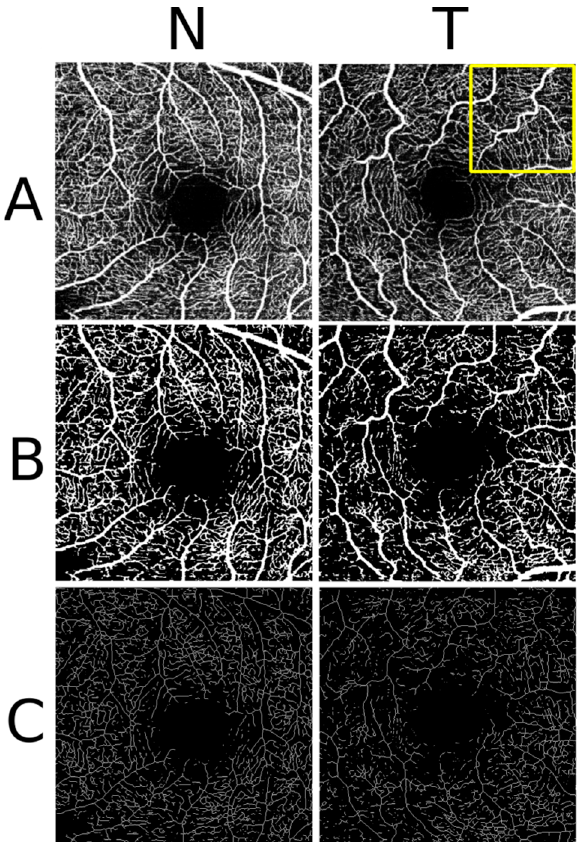
Figure 1. ( Left ): ‘N’ OCT scan; ( Right ): ‘T’ OCT scan; from top to bottom: ( Panel A ): original image; ( Panel B ): binarized image (Method A); ( Panel C ): skeletonized image. Table 1. Tortuosity indexes and branch-related features of the two exemplificative OCT images, calculated by means of the four investigated methods.